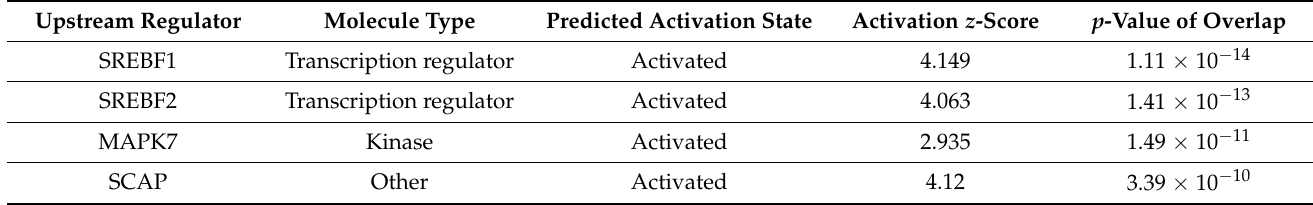
Table 2. Upstream regulators of DEGs. The top upstream regulators of DEGs (|fold changes| > 1.5, p -value < 0.01) in PM 2.5 -treated SZ95 sebocytes were analyzed with IPA. Activation z-score indicates the predicted activation (positive value) or inhibition (negative value) of the upstream regulator. The p -value of overlap indicates the statistical significance of the overlap of the DEGs and genes regulated by an upstream regulator. p -values were calculated by right-tailed Fisher’s exact